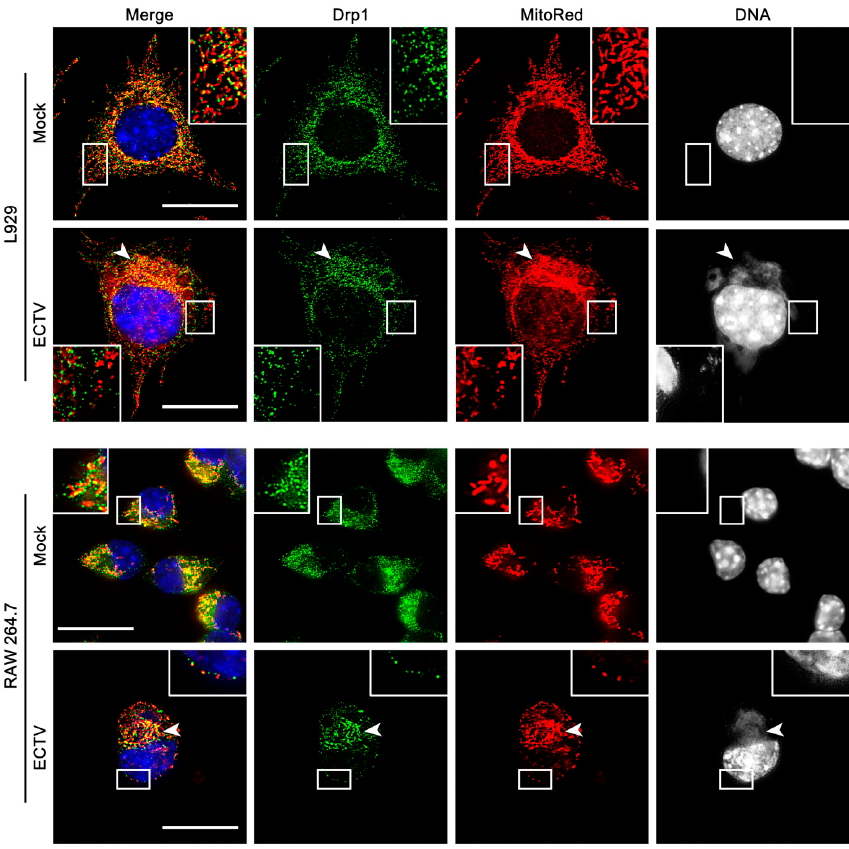
Figure 7. Distribution of Drp1 protein in L929 and RAW 264.7 cells at 18 hpi with ECTV. Mock-infected cells show regular distribution of Drp1. Arrowheads indicate accumulation of Drp1 in close association with viral factories that corresponds to the distribution of mitochondria. Scale bar: 10 µm.